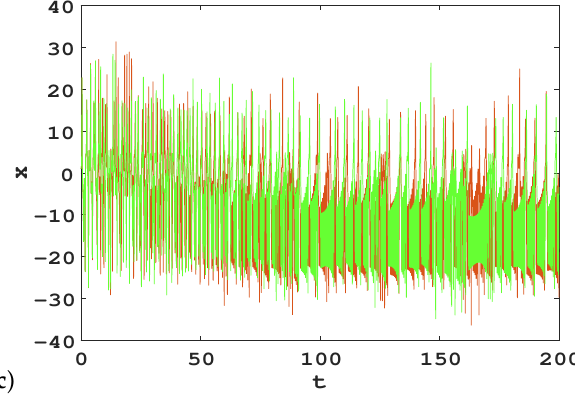
Figure 4. Time-sequence diagrams of system (2); ( a , b , c , k , m ) = ( 10,100,2.7, − 0.2,1 ) : ( a ) ( x 0 , y 0 , z 0 , w 0 ) = ( 1,1,1,1 ) ; ( b ) ( x 0 , y 0 , z 0 , w 0 ) = ( 1.001,1,1,1 ) ; ( c ) green and brown represent initial values of ( a , b ), respectively.